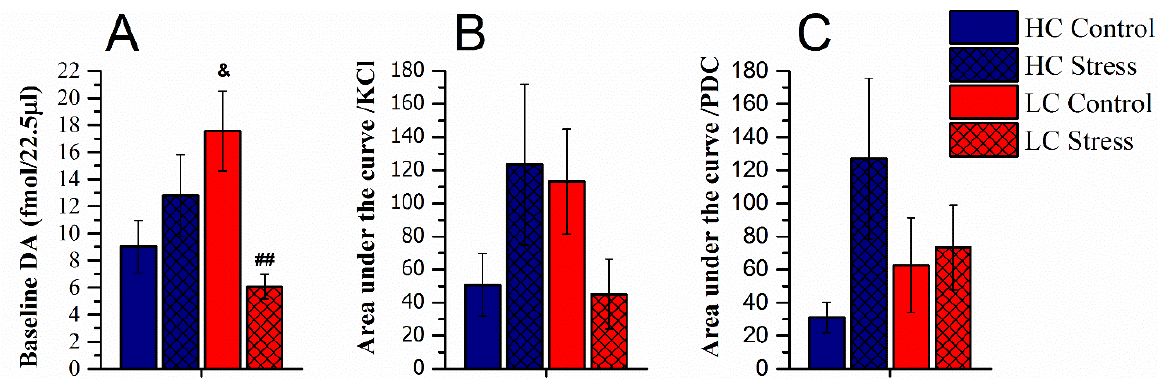
Figure 4. Extracellular dopamine levels in the NAc shell as measured during microdialysis (average ± SEM). ( A ) Average in baseline dopamine content (samples 2–4), ( B ) area under the curve (AUC) during and after perfusion with 50 mM KCl solution (samples 5–11), ( C ) area under the curve (AUC) during and after perfusion with 4 mM PDC (samples 13–20). ## p < 0.01 vs. LC-control; and p < 0.05 vs. HC-control. HC-controls, n = 8; HC-stress, n = 8; LC-controls, n = 7; and LC-stress: n = 6. HC, high 50-kHz USV rats and LC, low 50-kHz USV rats.